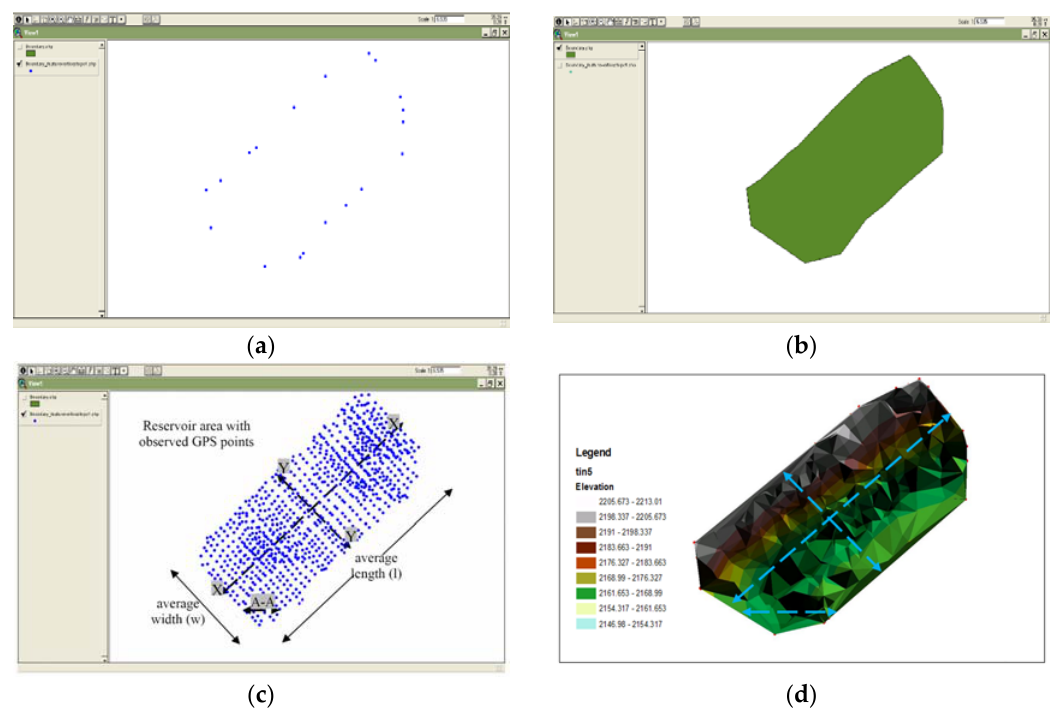
Figure 8. Proposed Kesses Reservoir II: ( a ) point coordinate data of the reservoir perimeter; ( b ) area polygon after merging points in ( a ); ( c ) location and distribution of measured 3D points within with an average point density of 874 m 2 /point; and ( d ) the derived terrain triangulated irregular networks (TIN) from ( c ).